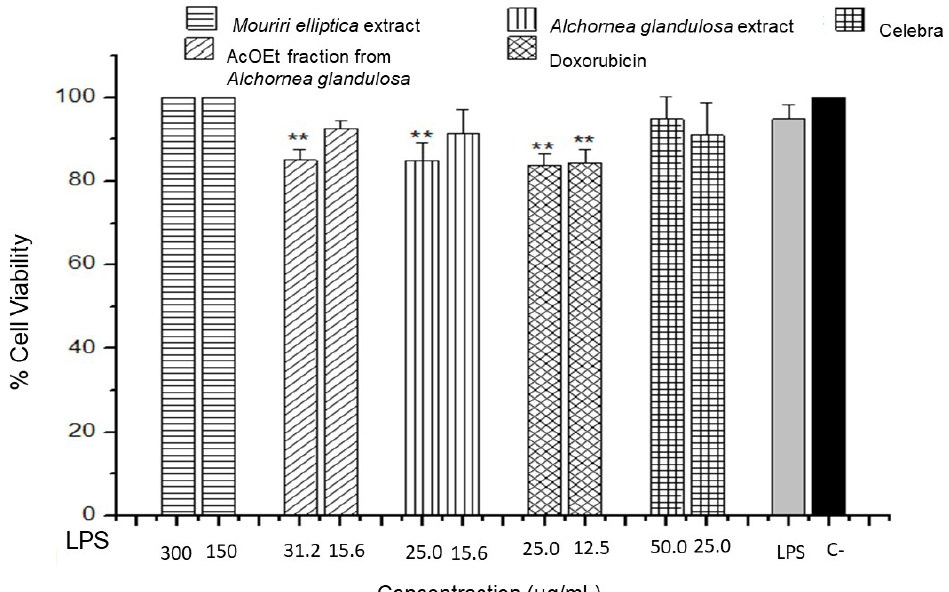
Figure 2. Viability of peritoneal macrophages of normal mice in the presence of different concentrations of extracts, fraction and drugs. Cells in culture medium (RPMI-1640) were used as negative control (C-) and LPS solution as positive control. ** P < 0.001 when compared to the negative control.